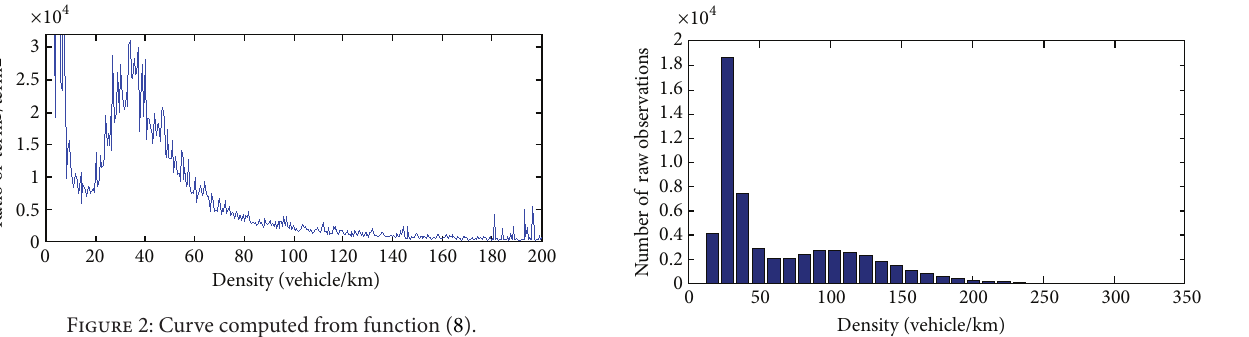
Figure 3: Number of raw observations which happened at different density